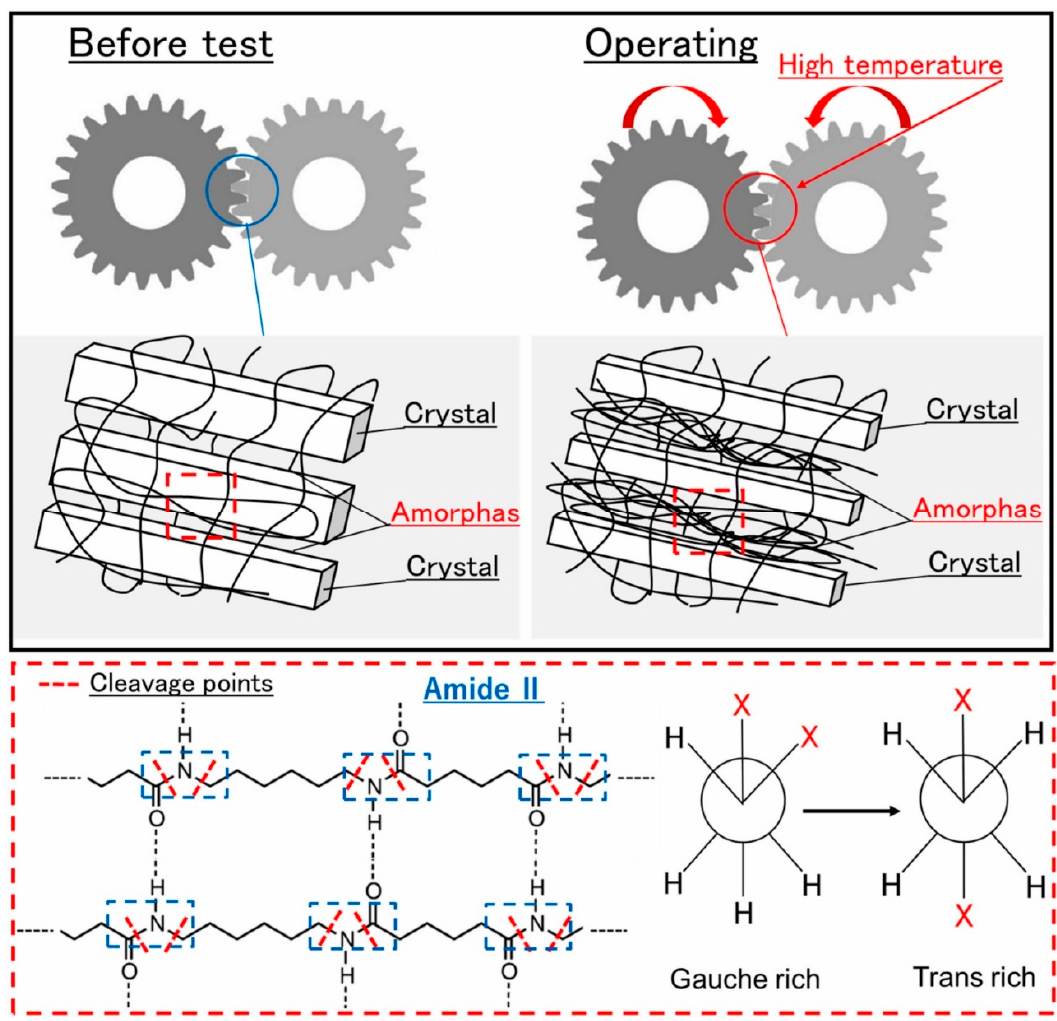
Figure 64. Schematic representation of the structural change of a PA 66 gear induced by self-heating effect during fatigue loading [193].